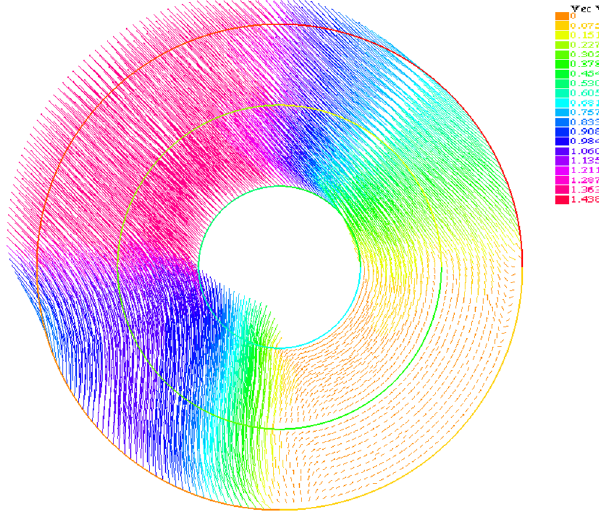
Fig. 5. Case of eigenvalues and eigenvectors.